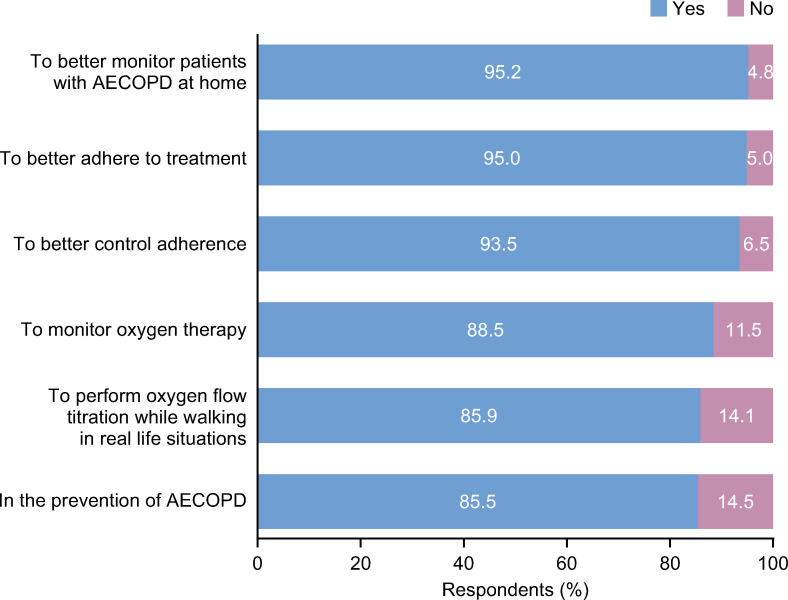
Key reasons respondents would use respiratory-connected devices.AECOPD, acute exacerbation of chronic obstructive pulmonary disease.